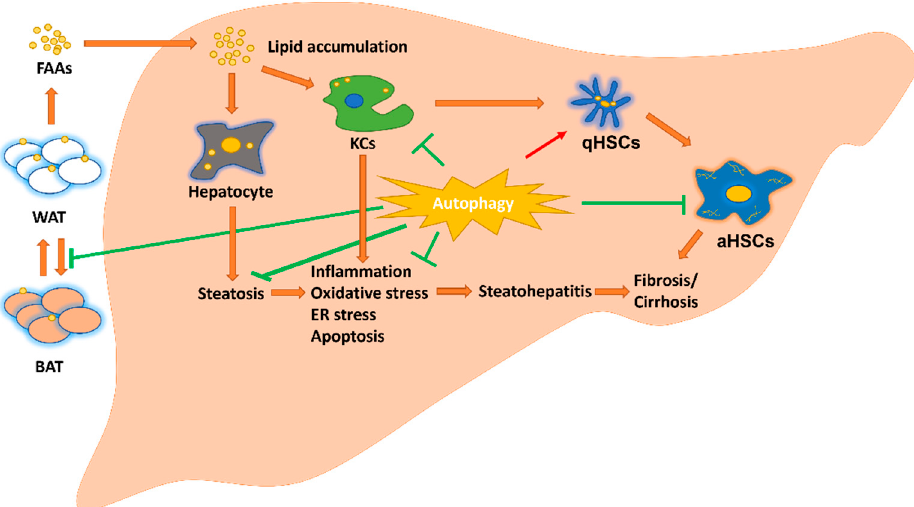
Figure 1. Regulation of autophagy on fatty liver pathogenic pathways. Autophagy inhibits hepatic steatosis, inflammation, oxidative stress, ER stress, apoptosis, and M1 KCs polarization. Autophagy induces M2 KCs. Autophagy may play a dual role in HSC activation. aHSCs: activated hepatic stellate cells; BAT: brown adipose tissue; ER: endoplasmic reticulum; FFAs: free fatty acid; KCs: Kupffer cells; qHSCs: quiescent hepatic stellate cells; WAT: white adipose tissue.